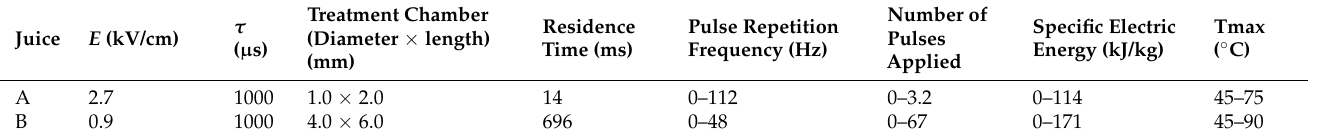
Table 1. Characterizations of the pulse conditions and configurations used to apply a moderate intensity PEF treatment at a flow rate of 13